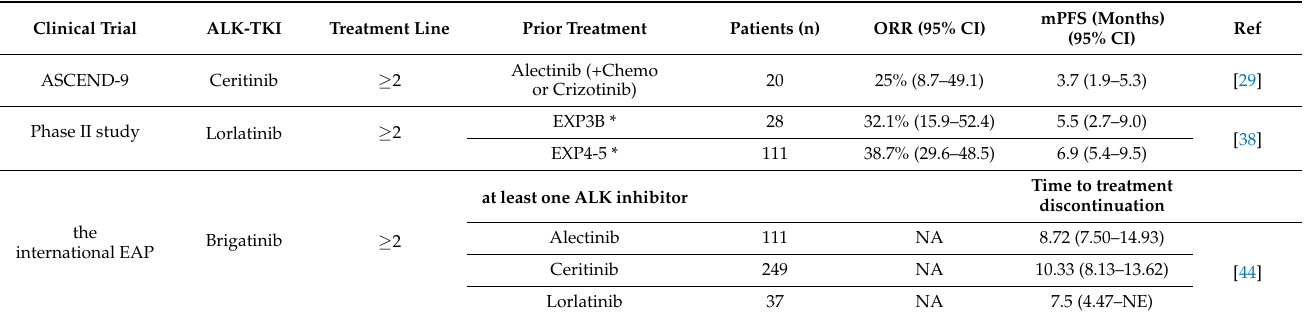
ORR: overall response rate, mPFS: median progression-free survival, median overall survival. Table 2. Efficacy following second-generation TKI treatment.